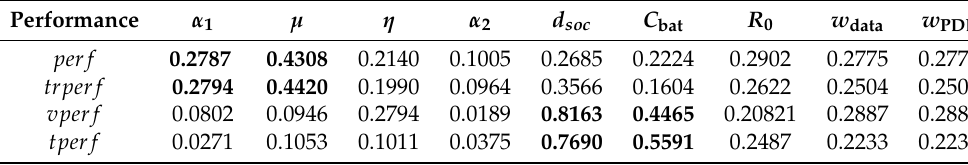
Table 4. Correlation coefficients of performance with sensitive